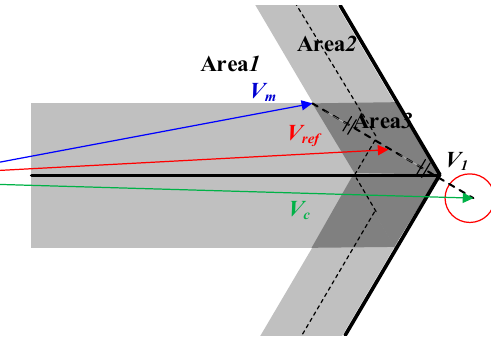
Figure 12. Voltage injection method in Area 3 beside a vertex of the hexagon.